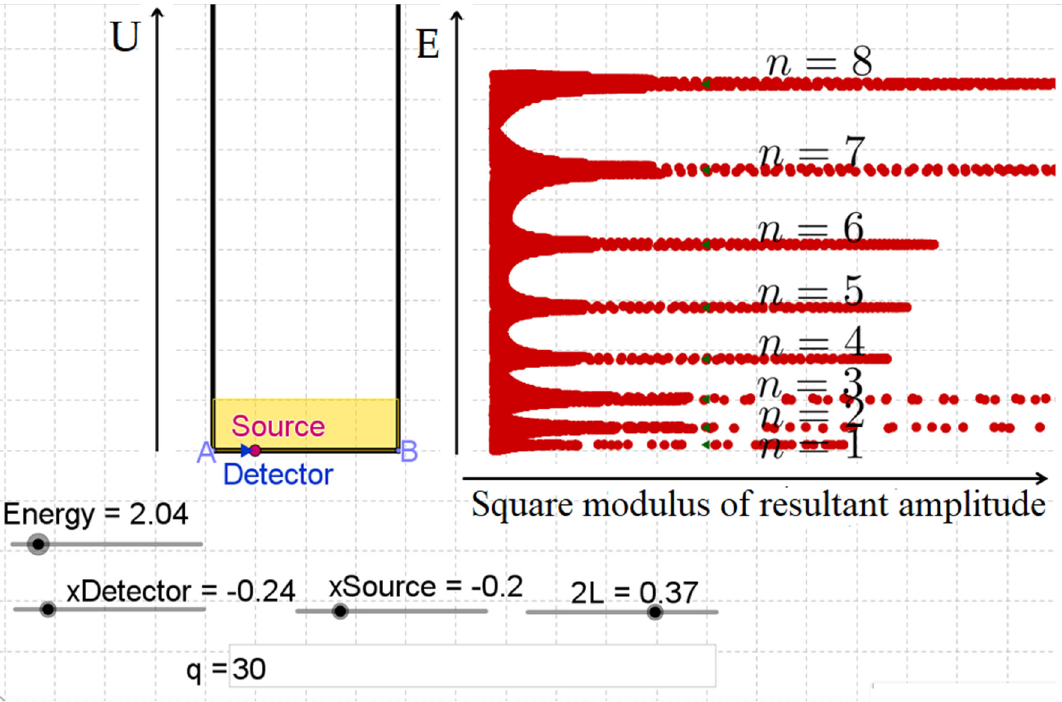
Figure 5. Graph of the approximate spectrum of the particle-in-a-box system when only a finite number of paths (here, N = 120 for all values of energy) is considered. The red dot represents the source, the green triangle the detector. The spread of spectral lines corresponding to energy levels into Lorentzian-like shapes is evident. The width of the peaks is not uniform because in this simulation N is kept fixed for all values of energy rather than depending on a fixed time uncertainty, ∆ t, and the particle momentum, p .